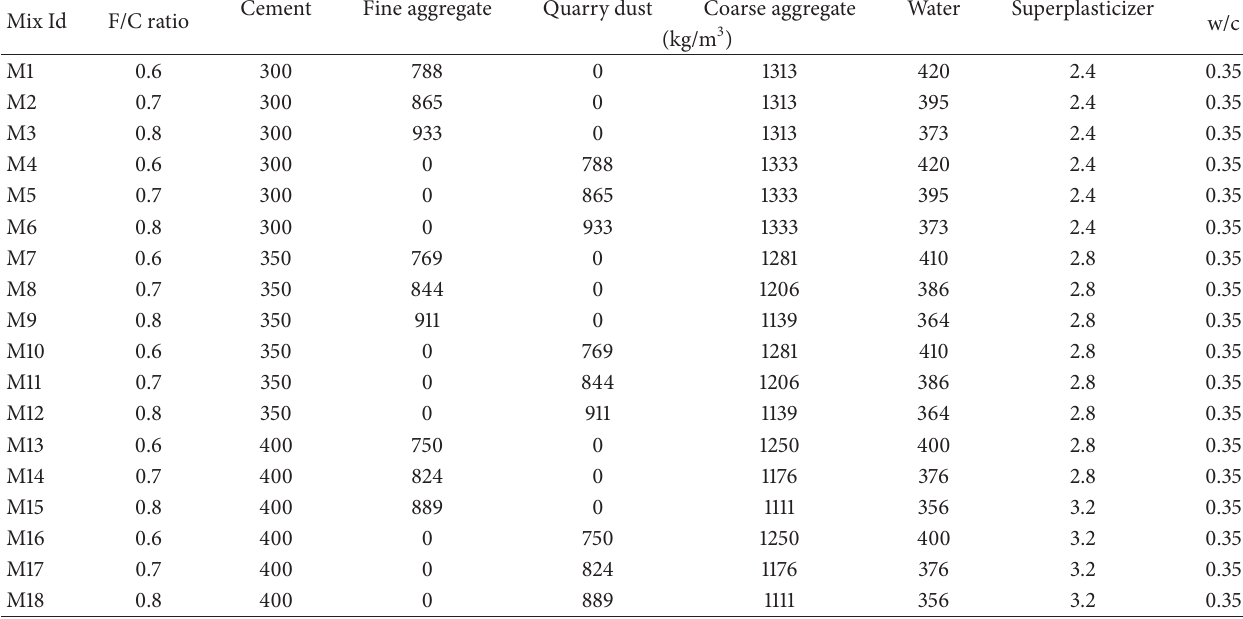
Table 1: Various concrete mixture proportions used in the